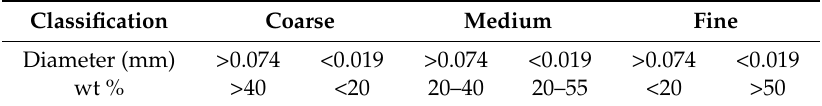
Table 2. Generally accepted classifications for various tailings in China.